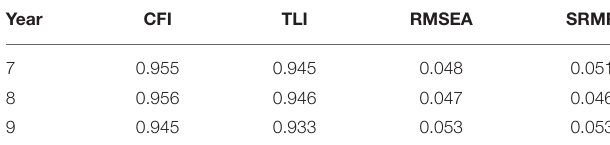
TABLE 2 | Cronbach’s alpha reliabilities of the engagement scales across 3 years. Behavioral Engagement